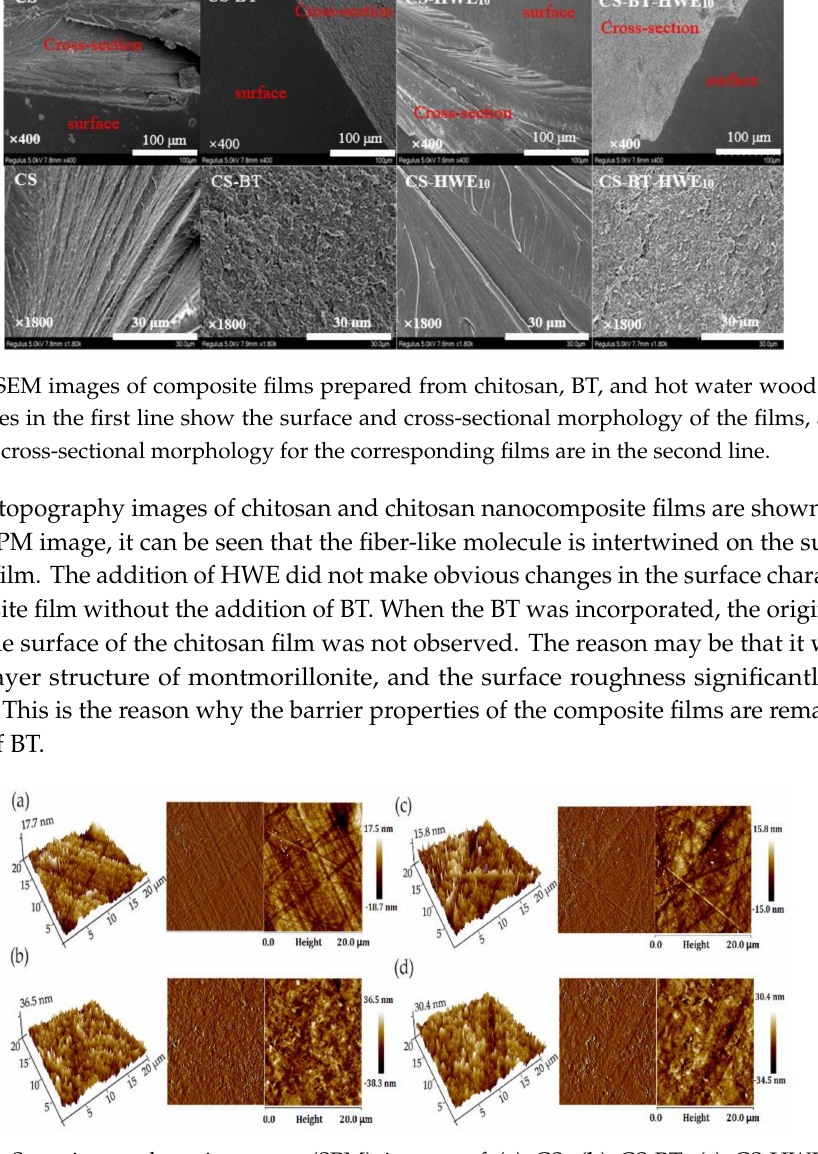
Figure 5. Scanning probe microscope (SPM) images of ( a ) CS, ( b ) CS-BT, ( c ) CS-HWE 10 and ( d ) CS-BT-HWE 10 . The scanning scale is 20 × 20 µ